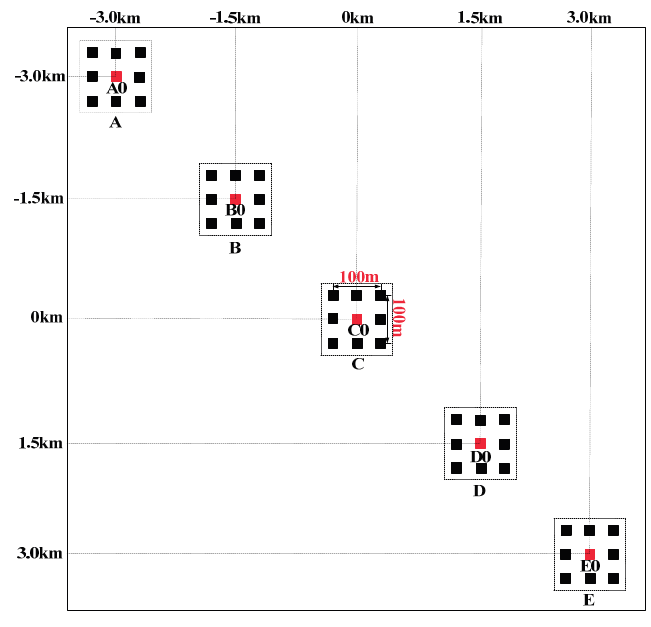
Figure 7. Distribution of the simulation